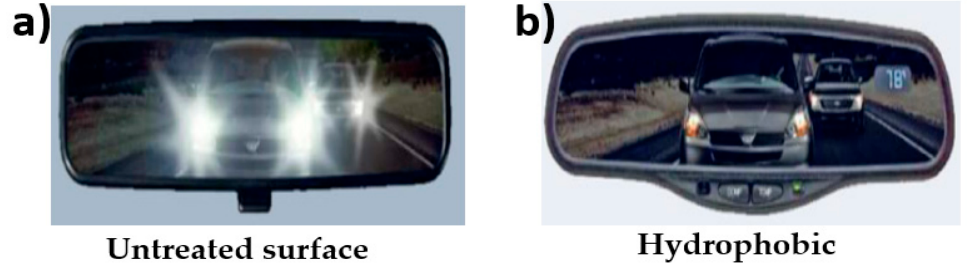
Figure 7. Representing the surface properties on glass plates in ( a ) conventional mirror (untreated surfaces) and ( b ) modern antiglare mirror (hydrophobic) [38].